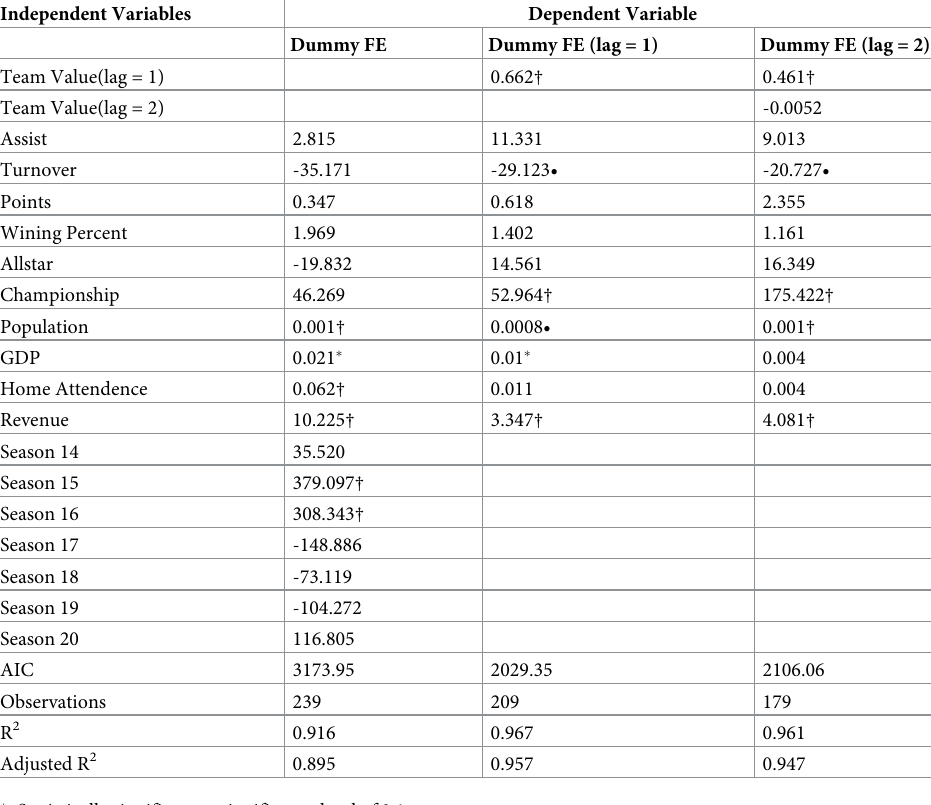
Table 5. Comparison of fixed effects